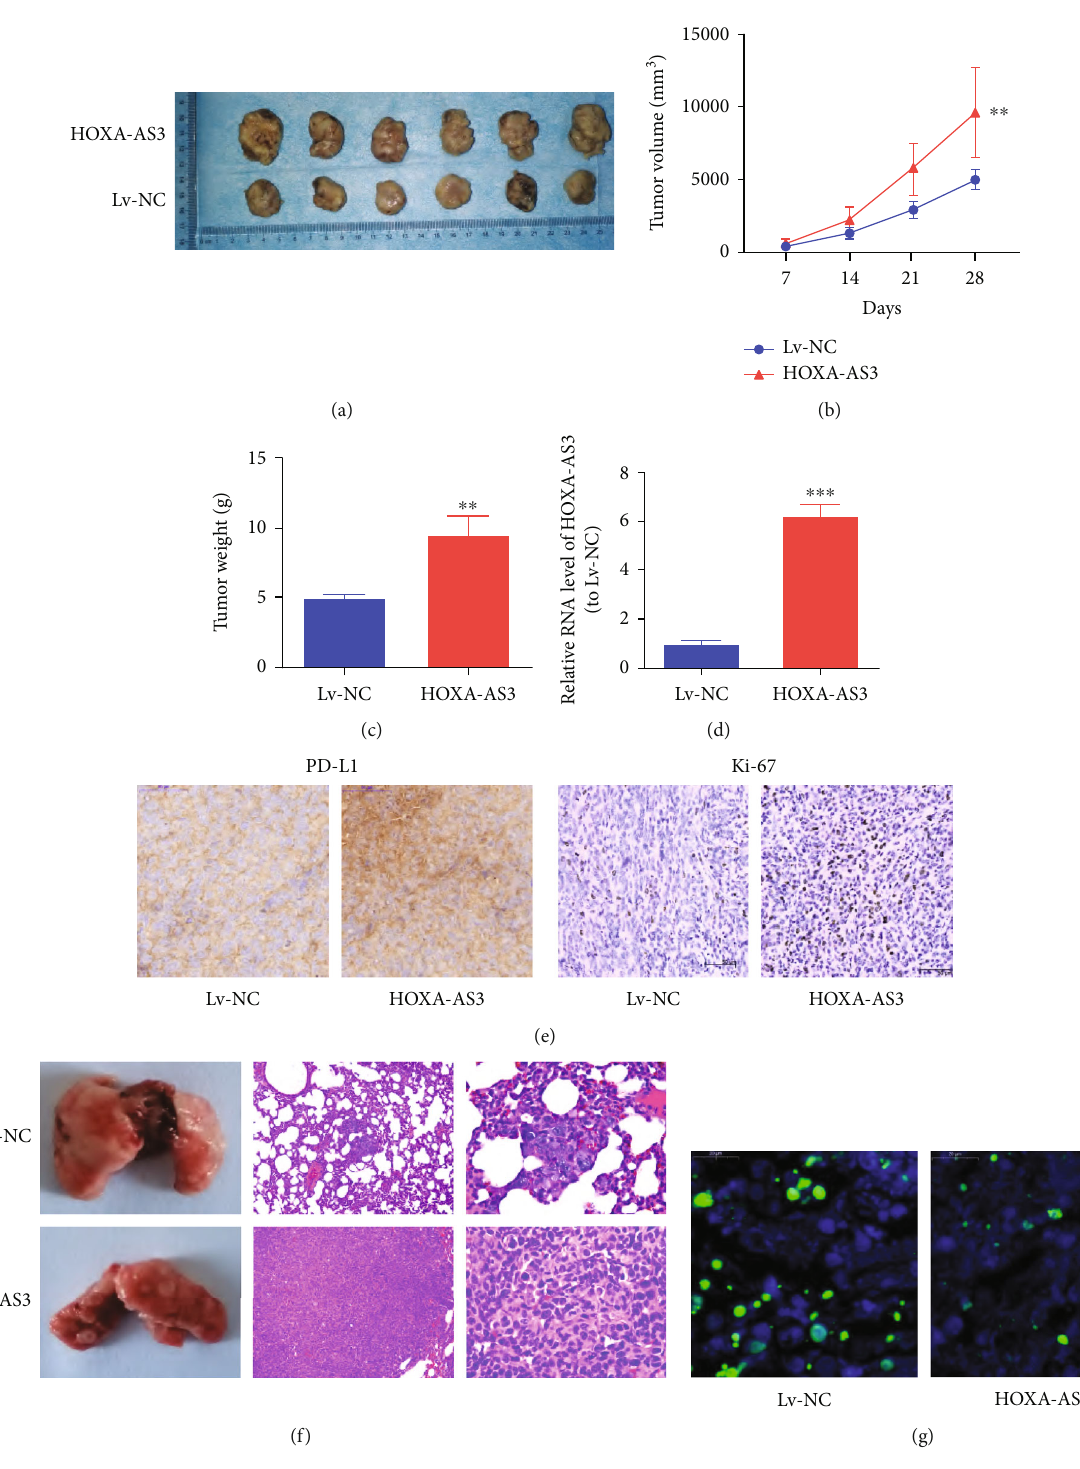
Figure 5: HOXA-AS3 overexpression promotes the tumor growth and metastasis in vivo. (a) Xenograft tumors. (b) Faster growth of xenograft tumors from HOXA-AS3 cells vs. tumors from Lv-NC cells. (c) Xenograft tumor weight. (d) Detection of HOXA-AS3 expression in xenograft tumors. (e) Overexpressed HOXA-AS3 notably contributes to PD-L1 and Ki-67 levels in tumors vs. the negative control group ( bar = 50 μ m). (f) Upregulation of HOXA-AS3 contributes to tumor metastasis in vivo . Typical microscopic and macroscopic images of lungs (H&E staining). (g) Upregulation of HOXA-AS3 represses apoptosis ( bar = 20 μ m). ∗∗ P < 0 : 01 and ∗∗∗ P < 0 : 001